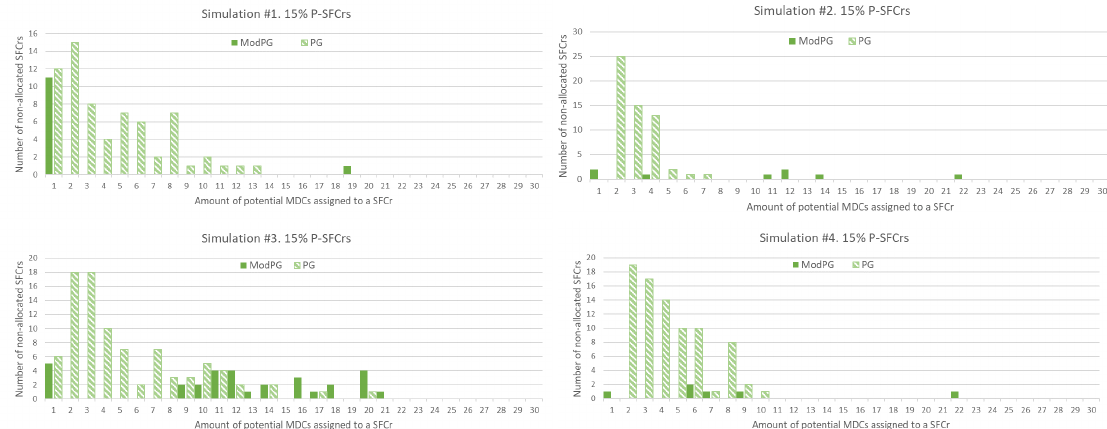
Figure 5. Detailed analysis of non-allocated SFCrs. Sets of 600 SFCrs with 15% P-SFCrs. Scenario 2: CPU and memory capacity of MDCs set to 4000.